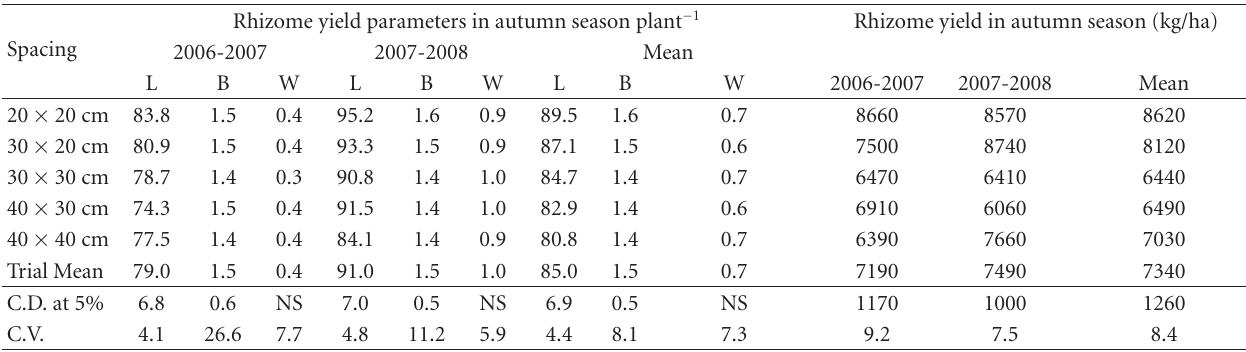
Table 4: Rhizome yield and yield-dependant parameters of Acorus calamus (sweet flag) planted with di ff erent spacings and harvested in single season over two year.